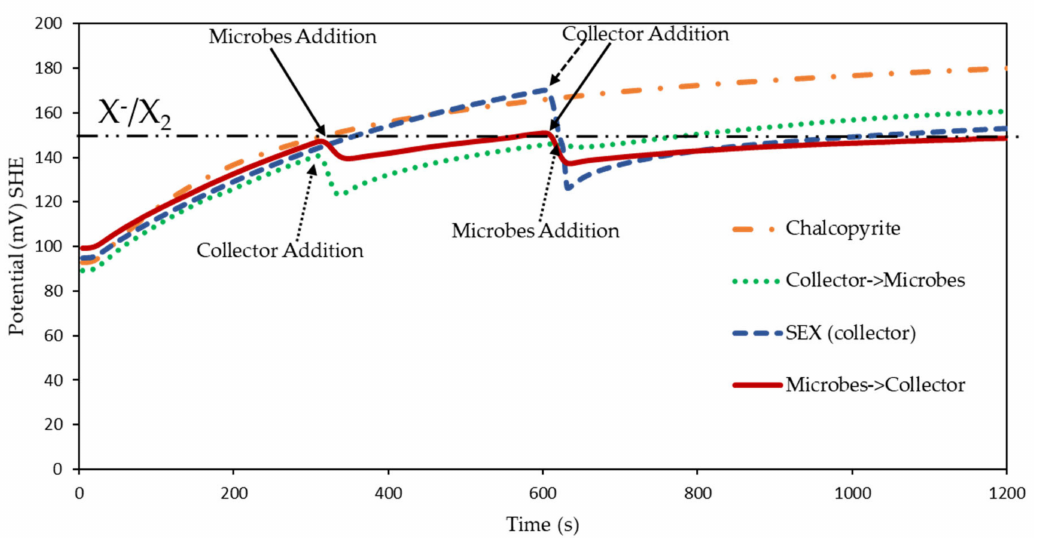
Figure 3. Mixed potential of chalcopyrite in the presence of 2.4 × 10 − 4 mol / L a sodium ethyl xanthate (SEX), 1 × 10 8 cells / mL microbes, 0.1 M Na 2 SO 4 and 0.05 M Na 2 B 4 O 7 (pH 9.3) at 25 ◦ C.